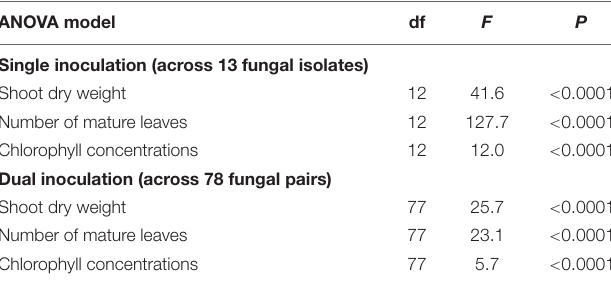
TABLE 2 | Analysis of variance (ANOVA) results of single- and dual-inoculation